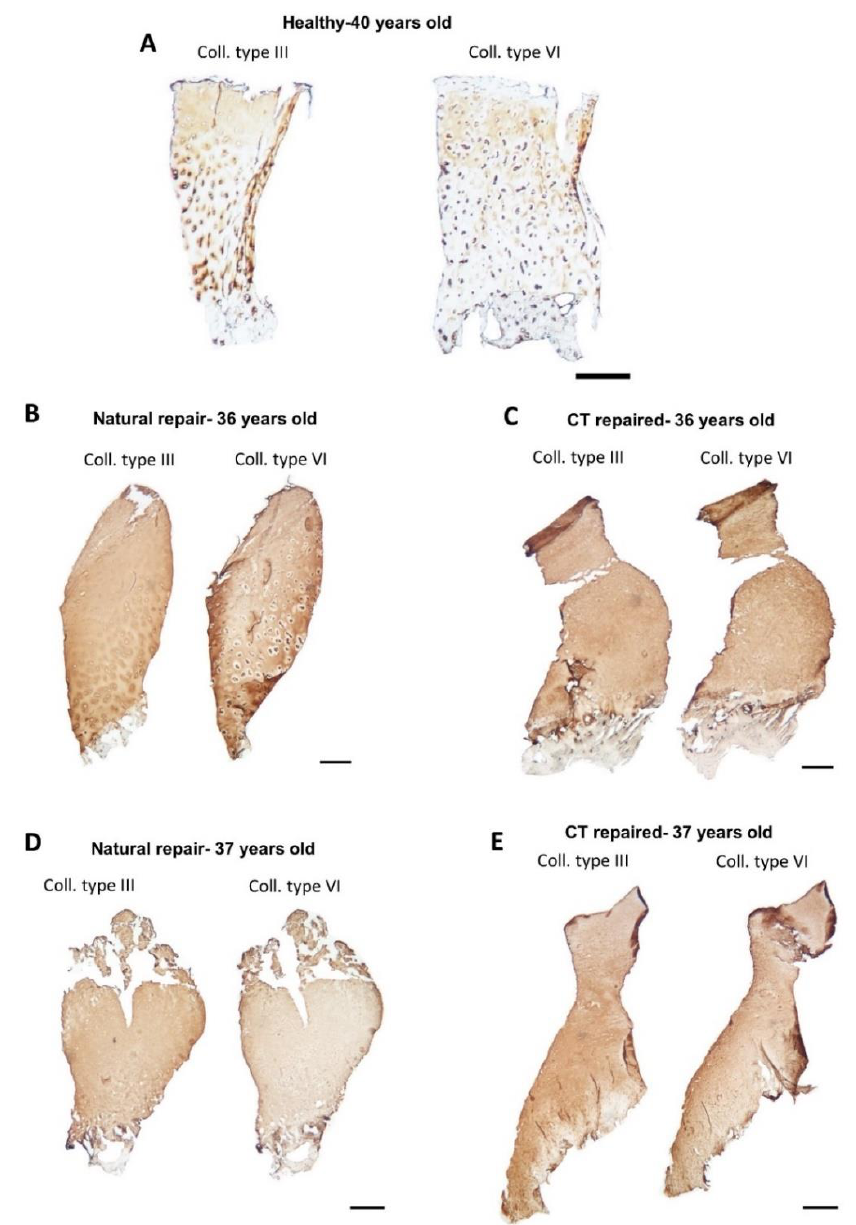
Figure 4. Immunohistochemistry of collagen types III and VI. Monoclonal and polyclonal antibodies were used to detect the presence of collagens type III and VI, respectively, in cryosections of core biopsies. For the repair tissues, two donor-matched samples of natural and cell therapy (CT) repaired cartilage are shown as representative examples (B + C = donor 7, D + E = donor 9). ( A ) Healthy cartilage showing interterritorial staining for collagen type III and pericellular staining for type VI (donor 15). ( B , C ) In this instance of hyaline-like cartilage in naturally repaired cartilage, the collagen type III was localised in the interterritorial region while collagen type VI was localised in the pericellular matrix. ( D , E ) Both collagens type III and VI are diffused in the matrix of fibrocartilage. Scale bar = 500 µm. Isotype controls found in Figure S1D,E.